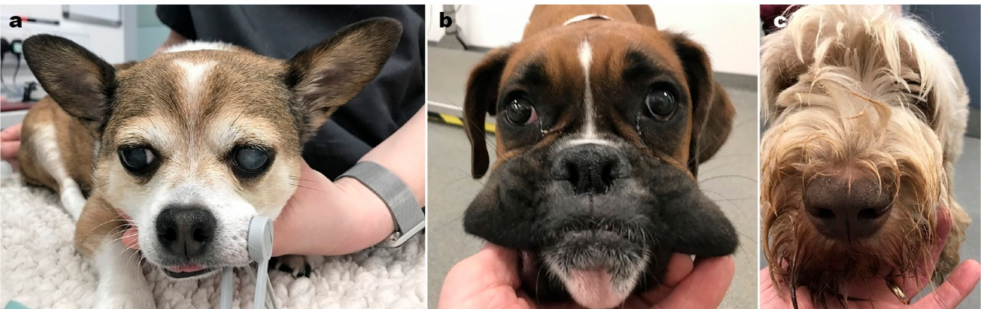
Figure 4. Ear carriage in dogs: ( a ) erect, ( b ) semi-erect and ( c ) pendulous ears.